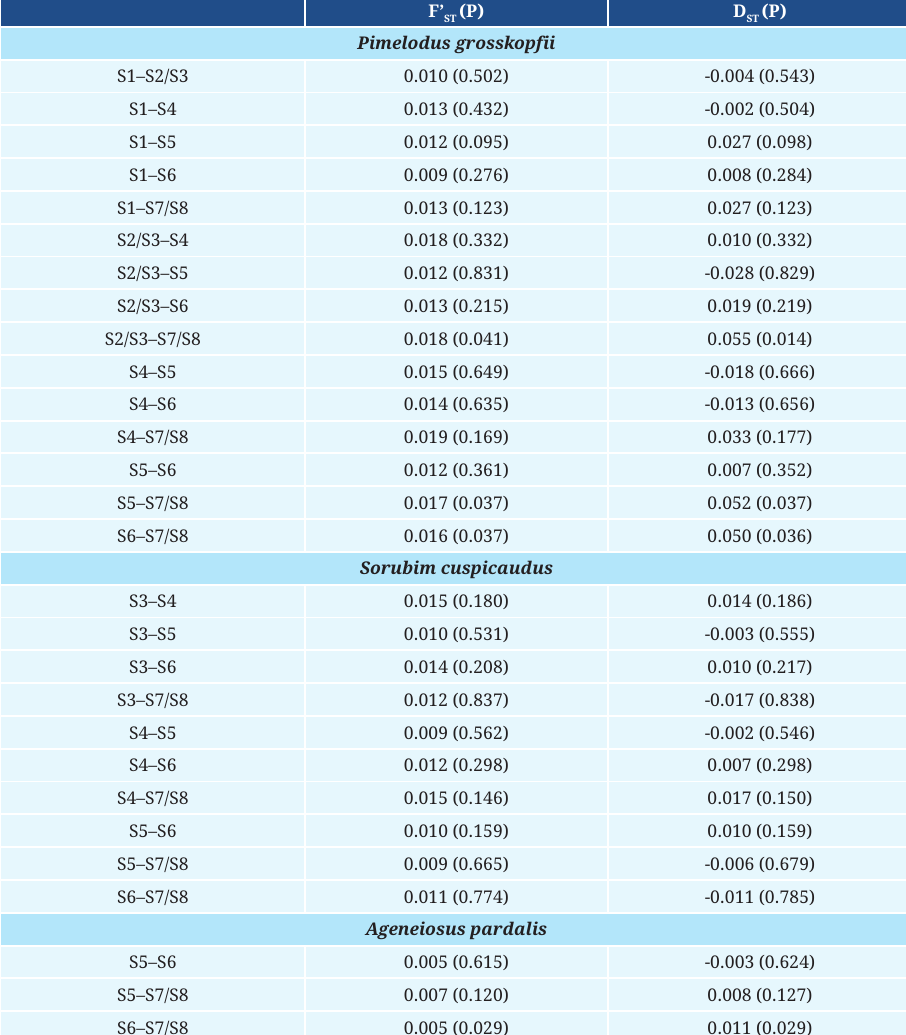
TABLE 3 | Statistical values F’ and Dest by pairs of the Pimelodus grosskopfii , Sorubim cuspicaudus , and ST Ageneiosus pardalis populations in middle and lower sections of the Cauca